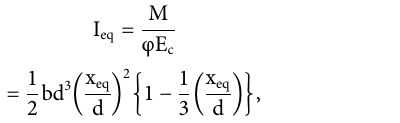
FIGURE 8 Strain pro fi le of slab SRC + 2T.